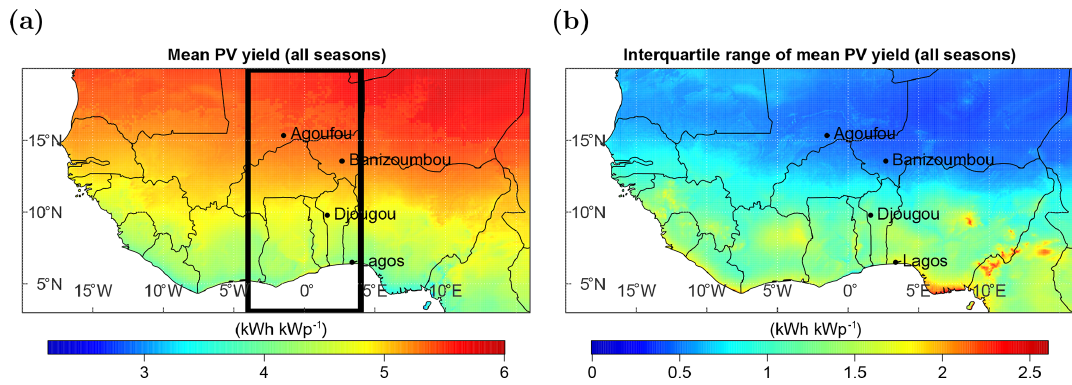
Figure 10. The annual mean (1983–2017) PV yield (a) and its interquartile range (b) over the full region. The black box in (a) marks the longitude range for Fig. 11.